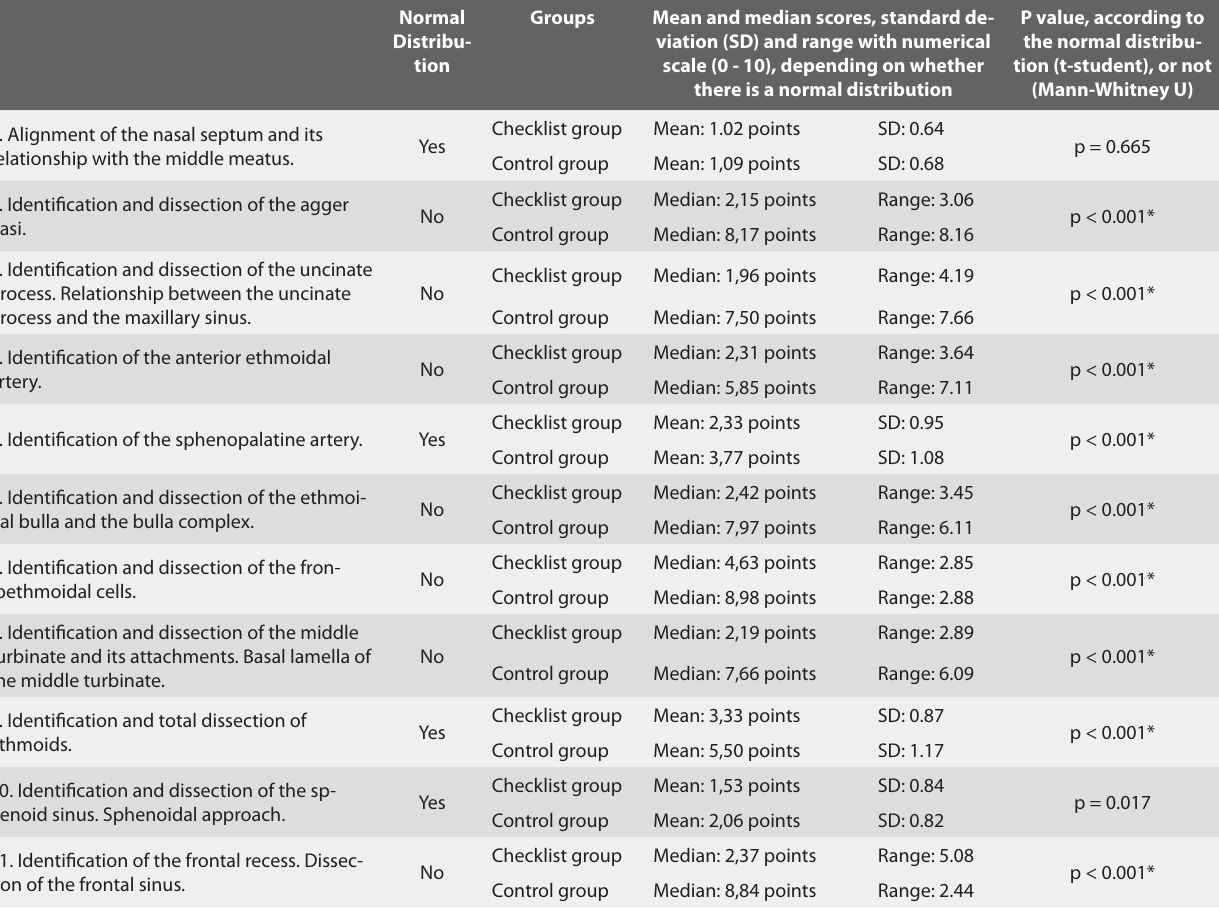
Table 2. Values of mean, median, standard deviation, range and statistical significance between the study groups (Checklist group and Control group), according to the data of normal distribution for the 11 essential anatomical references considered in the study. The difficulty measured by the numer- ical scale indicates that 0 points is the least possible difficulty during identification and subsequent dissection, and 10 points is the greatest possible difficulty.